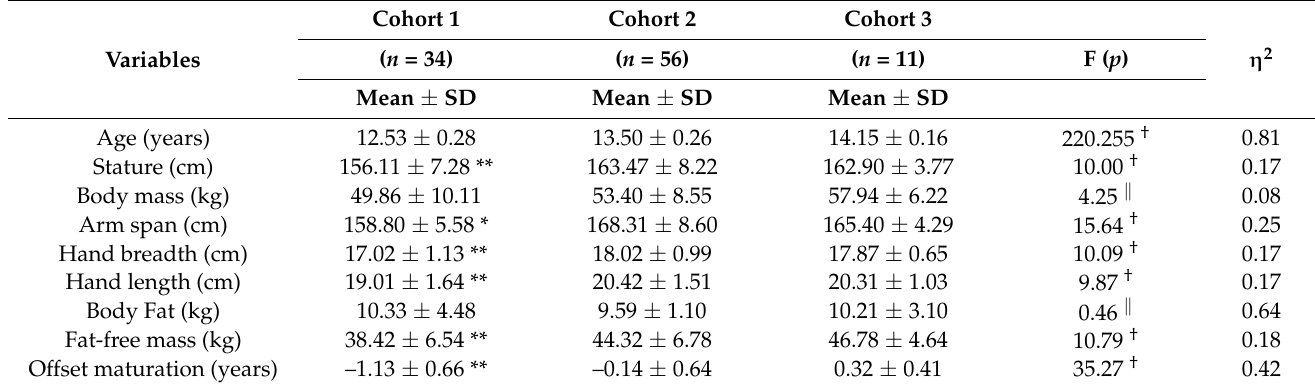
Table 1. Mean ± SD values of age-group players’ anthropometrics.